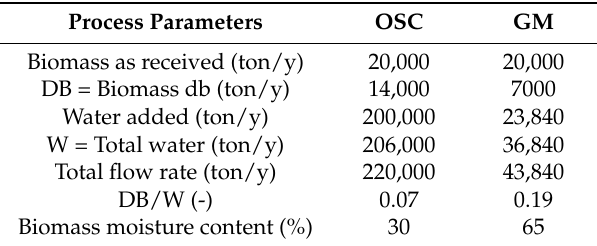
Table 1. Mass flow rates entering the HTC plant. The feedstock moisture content and the dry biomass to water ratio are also